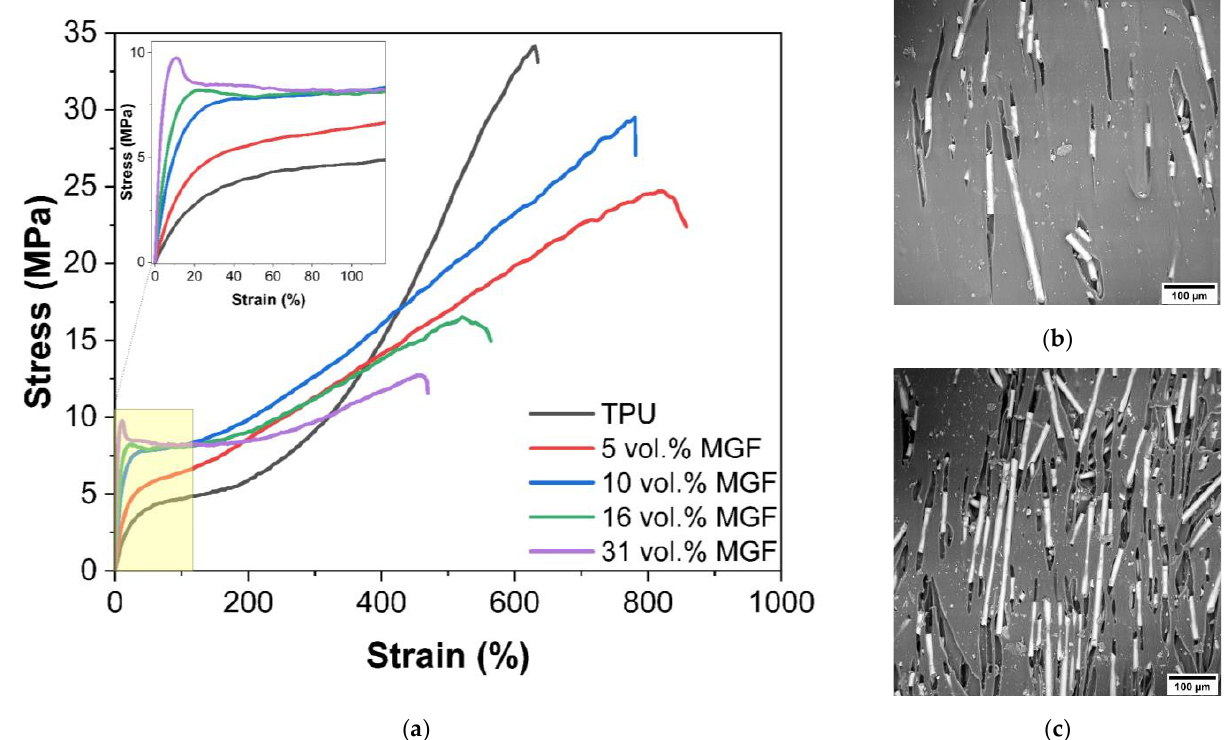
Figure 3. Stress-strain curves for samples with different MGF content ( a ) and SEM images of the surface of samples with 10 ( b ), 31 vol.% ( c )